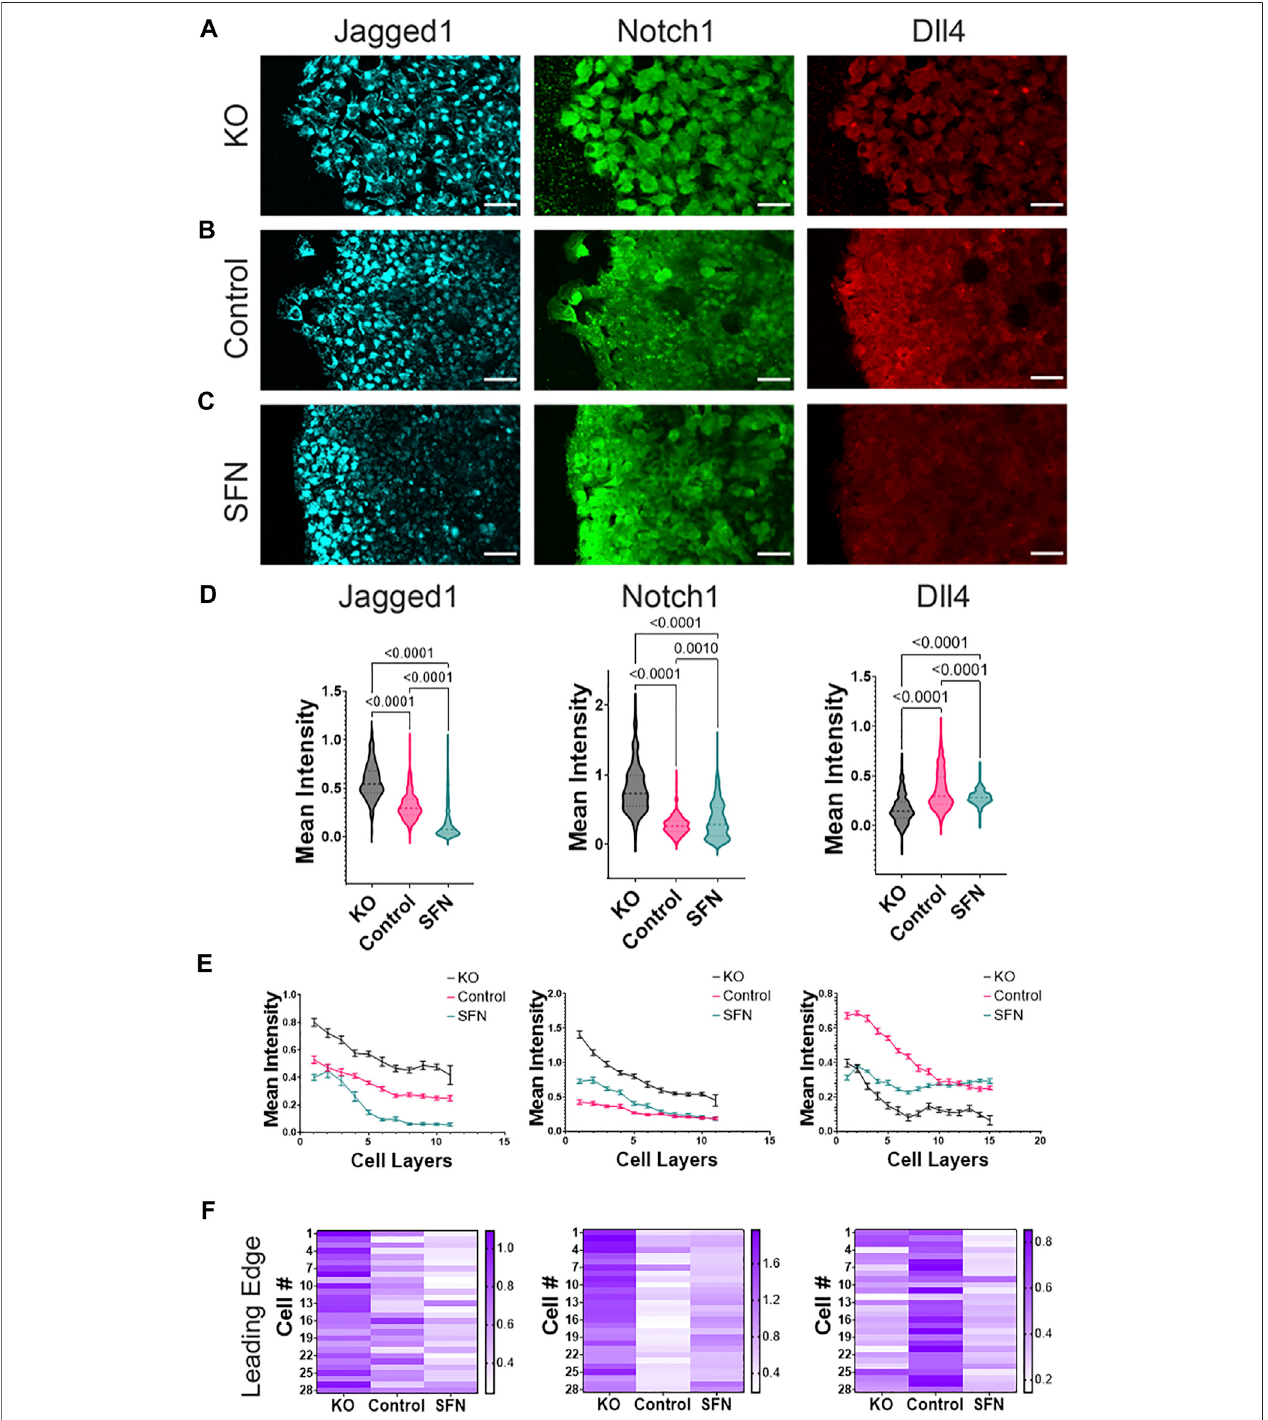
FIGURE 3 | Nrf2 regulates the Notch signaling pathway in the migrating front. (A – C) Immunocytochemistry of RT4 bladder cancer cells measuring Jagged1 (left column), Notch1 (center column), and Dll4 (right column) protein levels in a cell migration assay for (A) CRISPR/Cas9 NFE2L2-KO Pool RT4 cells (KO), (B) RT4 cells (Control), and (C) sulforaphane treated (7.5 μ M, 24 h) RT4 cells (SFN), respectively. Scale bars, 50 μ m. (D – F) Quanti fi cation of immunocytochemistry data. (D) Average intensity of each cell in the whole monolayer. One-Way ANOVA with post-hoc Tukey ’ s test was used to compare across groups (Jagged1: KO n = 307 cells, Control n = 526 cells, SFN n = 423 cells. Notch1: KO n = 307 cells, Control n = 370 cells, SFN n = 423 cells. Dll4: KO n = 460 cells, Control n = 1135 cells, SFN n = 570 cells). (E) Tracingofrelative fl uorescenceintensitypertissuedepthmeasuredasnumberofcelllayers.Datarepresentmean±S.E.M. (F) Heatmap ofrepresentativecells attheleadingedgeforJagged1,Notch1,andDll4,respectively.Eachcellattheleadingedgeisindicatedby “ Cell# ” wherecell#1referstothe fi rstmeasuredcellfromtop to bottom. Results are from four experiments performed across different